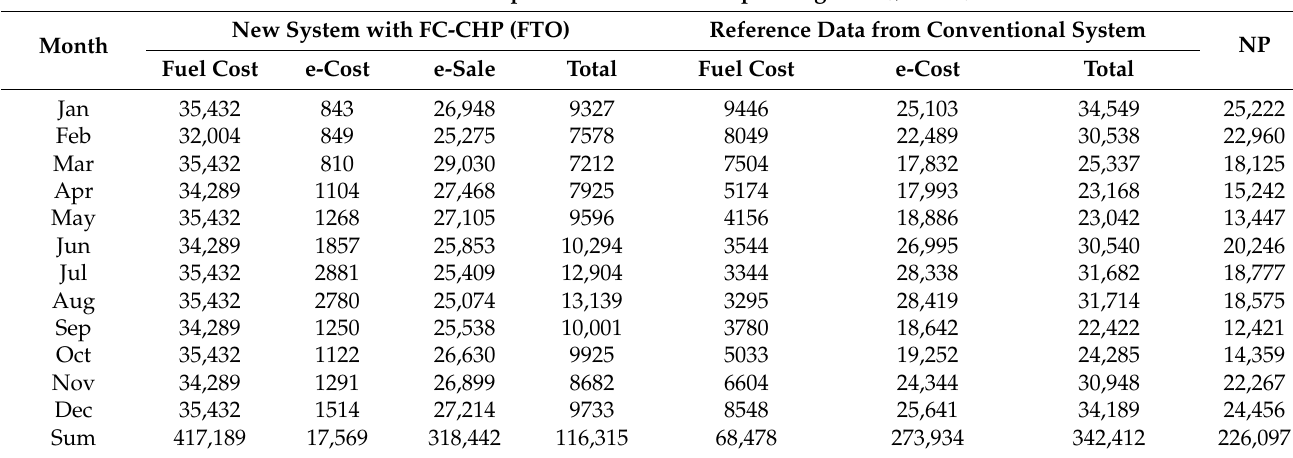
Table 7. Operating cost of the FC-CHP model under the FTO operating model and net profit (NP), in comparison with the conventional energy supply